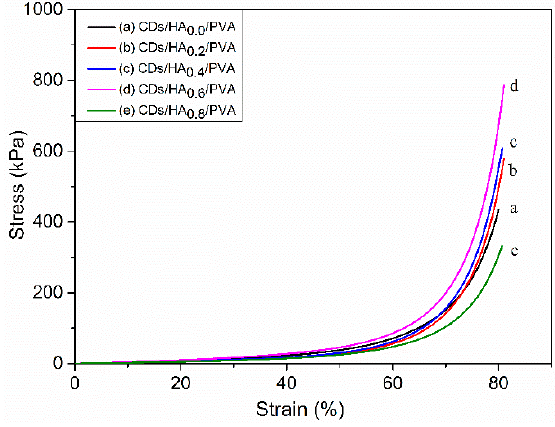
Figure 5. The compression stress ‒ strain curves of the CDs 3.0 /HA/PVA SN hydrogels with different mass ratios of HA to PVA at ( a ) 0.0, ( b ) 0.2, ( c ) 0.4, ( d ) 0.6, and ( e ) 0.8, respectively.